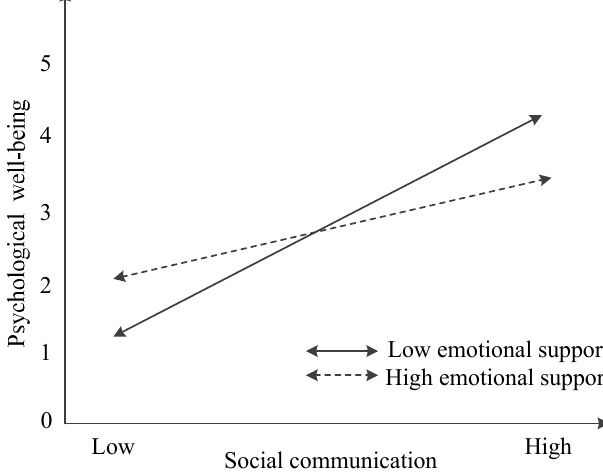
Figure 2. The moderating role of emotional support in the relationship between social communication and psychological and psychological well-being.